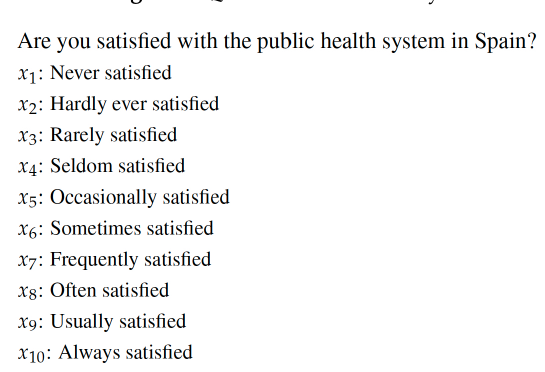
Figure 2. Question 1 under study.